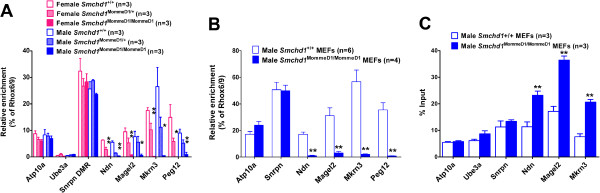
The epigenetic signature of deregulated genes in the Snrpn cluster is consistent with biallelic expression. The relative level of DNA methylation was quantified by qPCR of MeDIP recovered DNA in samples from (A) male and female E9.5 embryos, and (B) MEFs isolated from male E14.5 embryos. (C) The relative level of H3K4me2 for each gene was quantified by qPCR of ChIP recovered material in chromatin derived from MEFs isolated from male E14.5 embryos. The qPCR signal was normalized relative to that of Rhox6/9 for MeDIP or relative to input for the H3K4me2 ChIP. Results are plotted relative to the corresponding Smchd1+/+ sample. The genotype, sex, and number of replicates are indicated in each case. Statistical analysis was performed using the t test. In (A) **P < 0.01 or *P < 0.05 for Smchd1MommeD1/MommeD1 compared with Smchd1+/+. Statistical significance not shown for the comparison of Smchd1+/+ compared with Smchd1MommeD1/+. In (B) and (C) ** P < 0.01 compared with wildtype. Error bars indicate standard error. ChIP, chromatin immunoprecipitation.